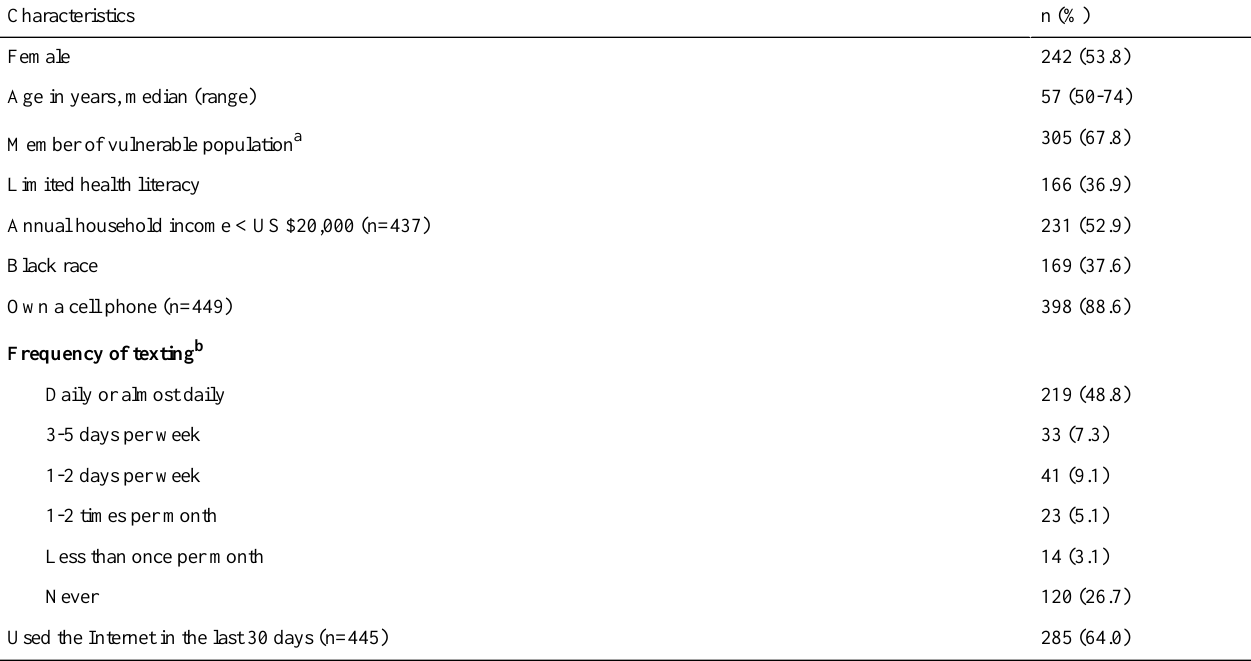
Table 1. Sociodemographic and technology use characteristics of the participants enrolling in a colorectal cancer screening trial